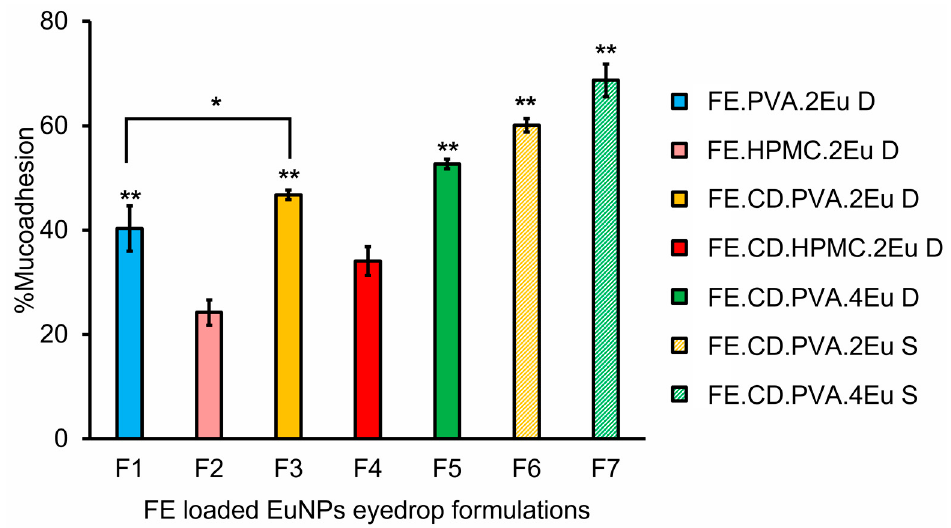
Figure 6. Percentage of mucoadhesion in FE-loaded EuNP eye drop formulations. D, dispersion; S, suspension. * Statistical difference (* p < 0.05, ** p < 0.01) when compared to the corresponding HPMC-based formulations (F2 or F4).